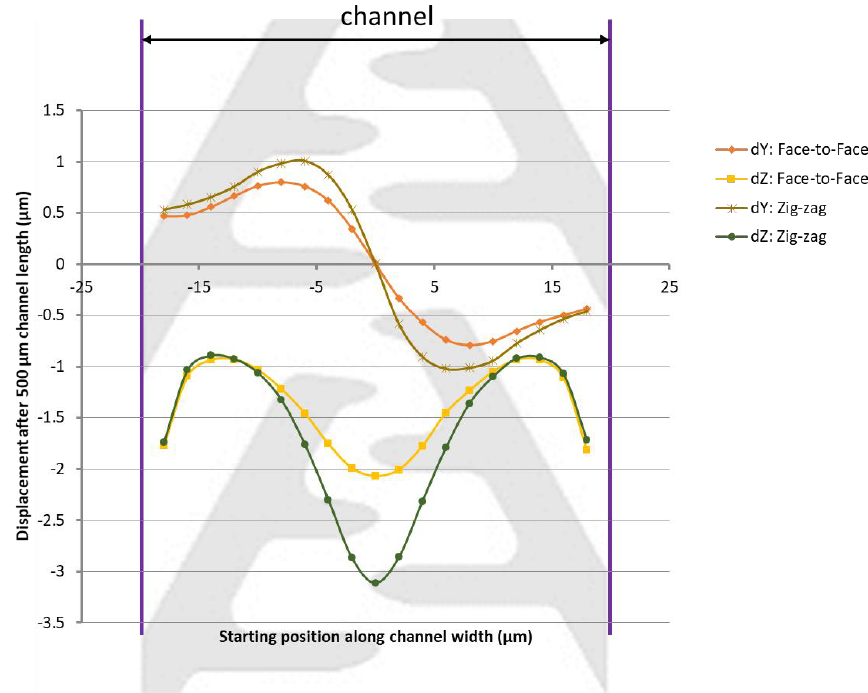
Figure 6. Particle displacement along the channel width (dY) and the channel height (dZ) after 500 µm of channel length under the influence of DEP forces.